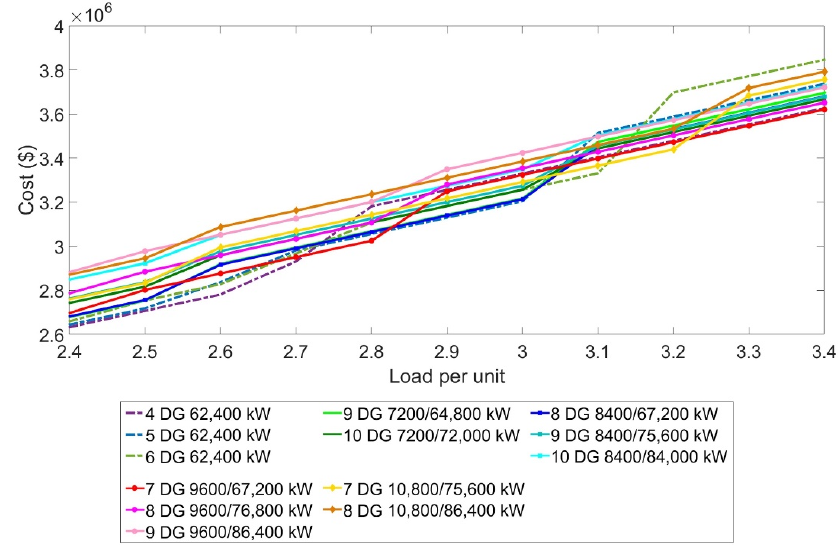
Figure 21. Total annual maintenance and repair costs of all configurations.